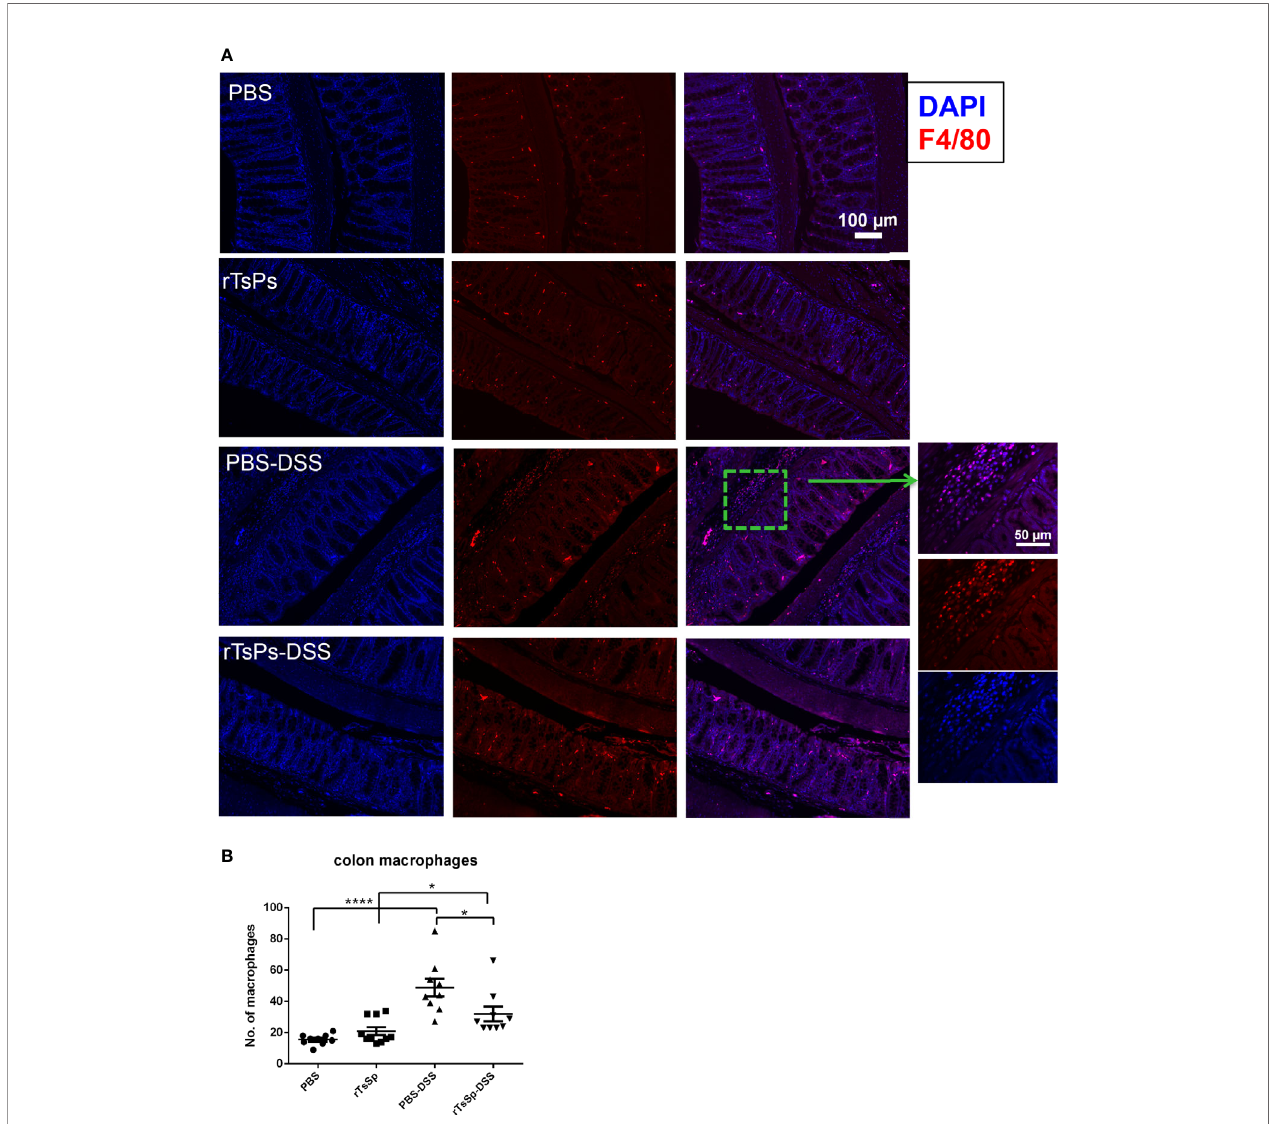
FIGURE 5 | Pre immunization with rTsSp reduces macrophages recruitment to the DSS induced colitis of the colon. (A) Colon slides from PBS control, rTsSp pre immunization, DSS treatment, rTsSp pre immunization and DSS treatment mice were stained with anti-F4/80 antibody for macrophages. The number of F4/80 + cells (B) detected in each high power fi eld was determined by counting 10 fi elds from each sample (samples from three mice per group were counted) using the Image J software. The data shown are means ± SEM. * P < 0.05, **** P <